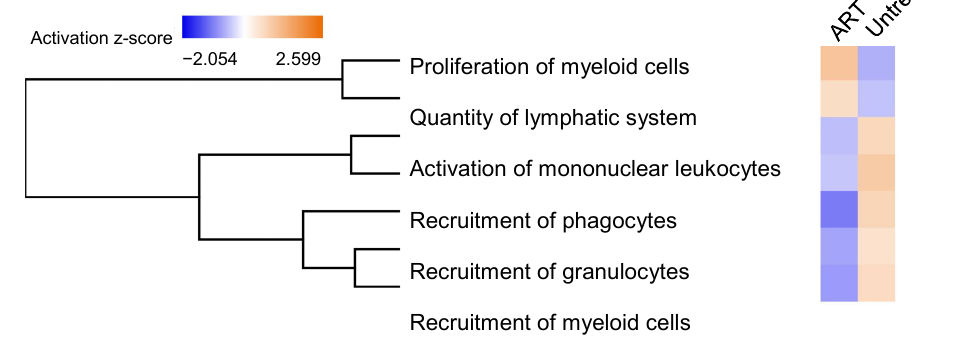
Figure 7. Biological Functional Annotations in Untreated vs. ART. DEGs in the ART and the untreated groups were analyzed. Differential pro-inflammatory functions were enriched for each group. The activation and inhibition of functions are shown by orange and blue colors, respectively. DEGs were defined by fold change >2 and p < 0.05.